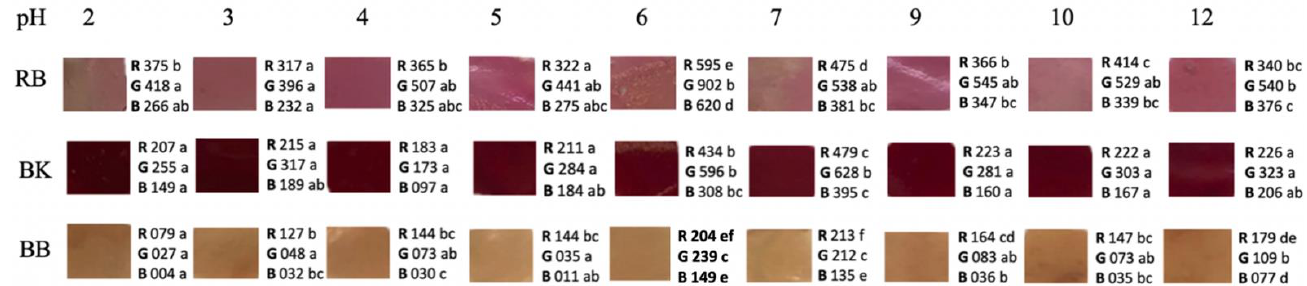
Figure 1. Films color changes at different pH value. RB (Raspberry), BK (Blackberry), and BB (Blueberry). Values followed by different superscript letters in the same row, for each parameter, indicate significant differences ( p < 0.05).